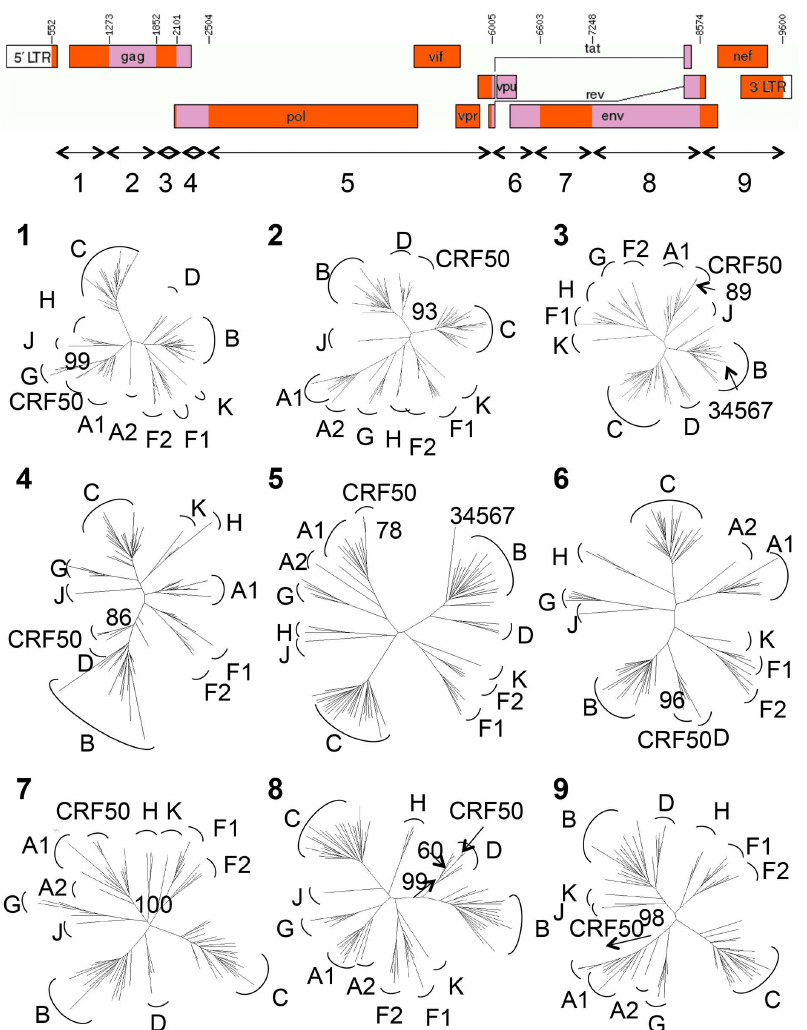
Figure 3. Recombinant map of CRF50_A1D and maximum likelihood phylogenetic trees of non-recombinant fragments. Maximum likelihood trees of putative non-recombinant fragments from specimens 33365, 8179, 40534 and 34567 drawn using PhyML with PAUP-defined parameters. HIV-1 subtypes used for analysis were A–D, F, G, H, J, K. Numbers indicate bootstrapping support from 1000 replicates (excepting slice 5; 100 replicates). 70% bootstrap support and monophyletic clustering were the criteria for subtype classification. The recombinant map was drawn using the RDT program at Los Alamos. Component subtype fragments are labeled 1–9 on the genome map, corresponding with numbered phylogenetic trees. The genomic regions in which the URF specimen 34567 did not cluster with the CRF50_A1D specimens are indicated in the appropriate trees.